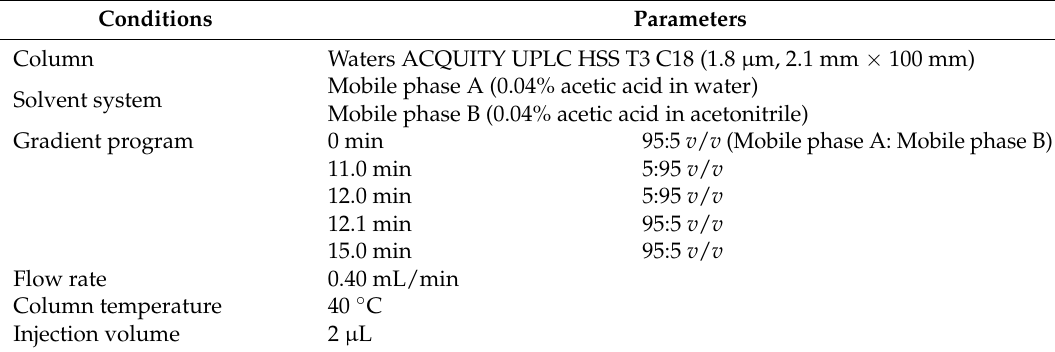
Table 1. Analytical conditions of the Ultra Performance Liquid Chromatography